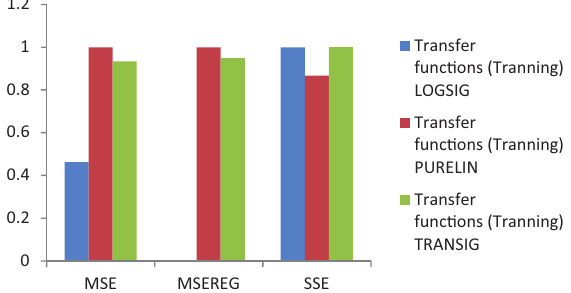
Figure 8. Neural Network Model of the system created by the MATLAB